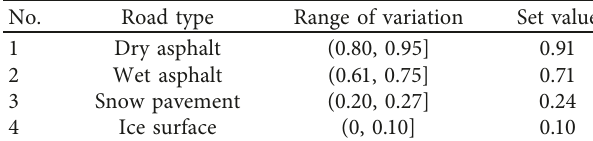
Table 3: Friction coefficients of four types of roads.